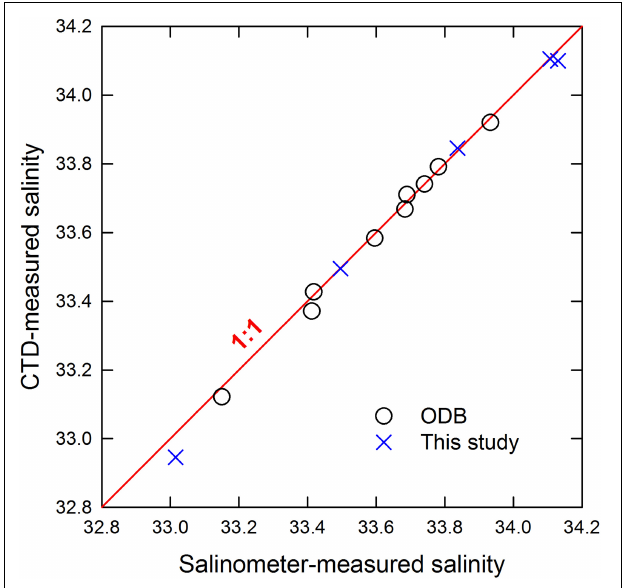
FIGURE 2 | AUTOSAL salinometer-measured salinity vs. CTD-measured salinity plot at SEATS. The solid line in red shows the 1:1 ratio.